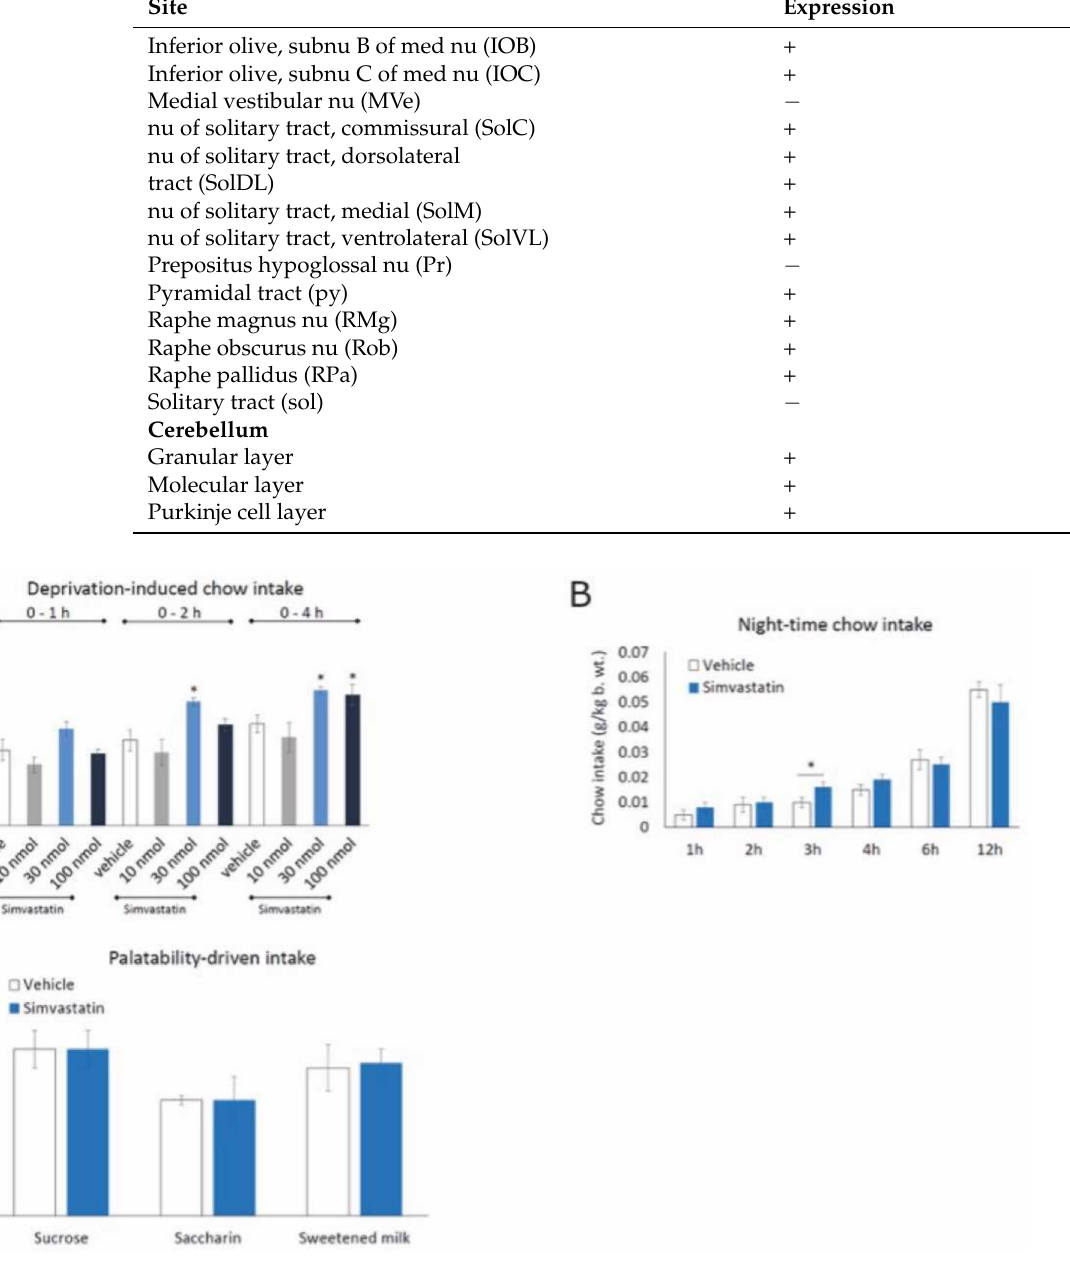
Figure 7. Simvastatin regulates neuronal activity in the hypothalamus. Effect of ICV simvastatin on ( A ) standard chow intake induced by overnight deprivation, ( B ) night-time chow intake, and ( C ) episodic (2 h) intake of palatable, energy-dilute solutions ( n = 6–7 rats per concentration per time point, one-way ANOVA with Bonferroni post hoc test for multiple comparisons, * p <